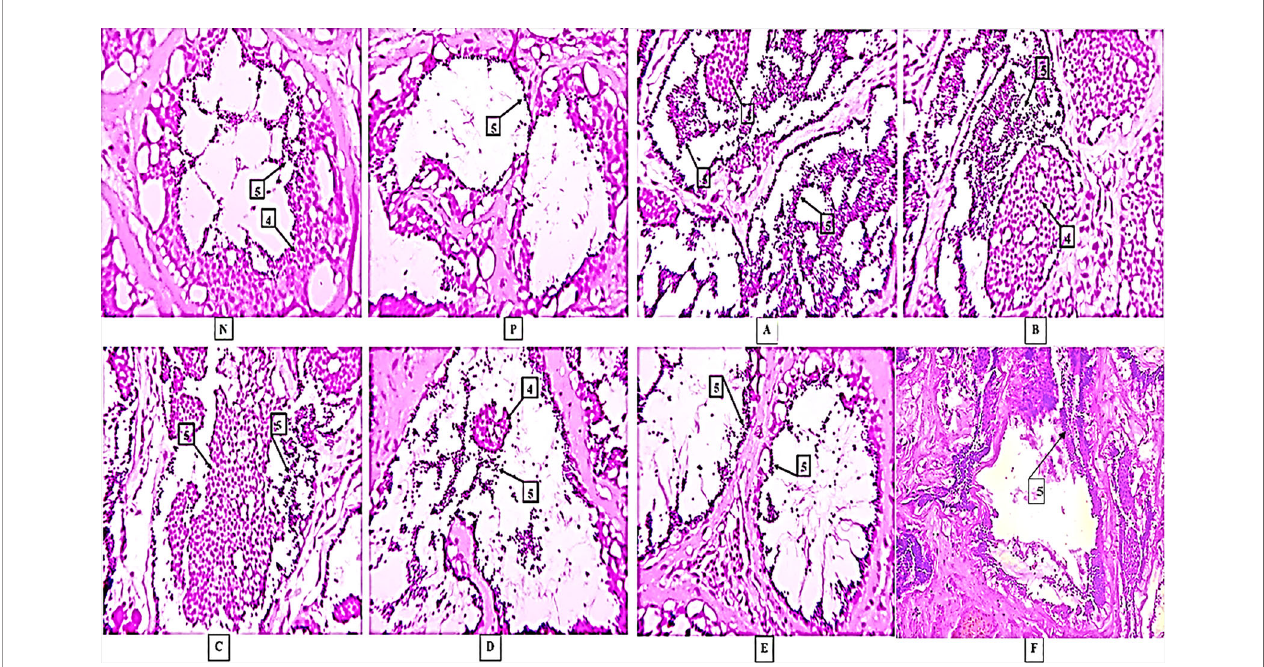
FIGURE 6 | Histological results in different treatments. Here, [N] Negative control and [P] Positive control 4-Spermatids, 5-Spermatozoa, (A – F) are treatments. The photographs were taken at a magni fi cation of